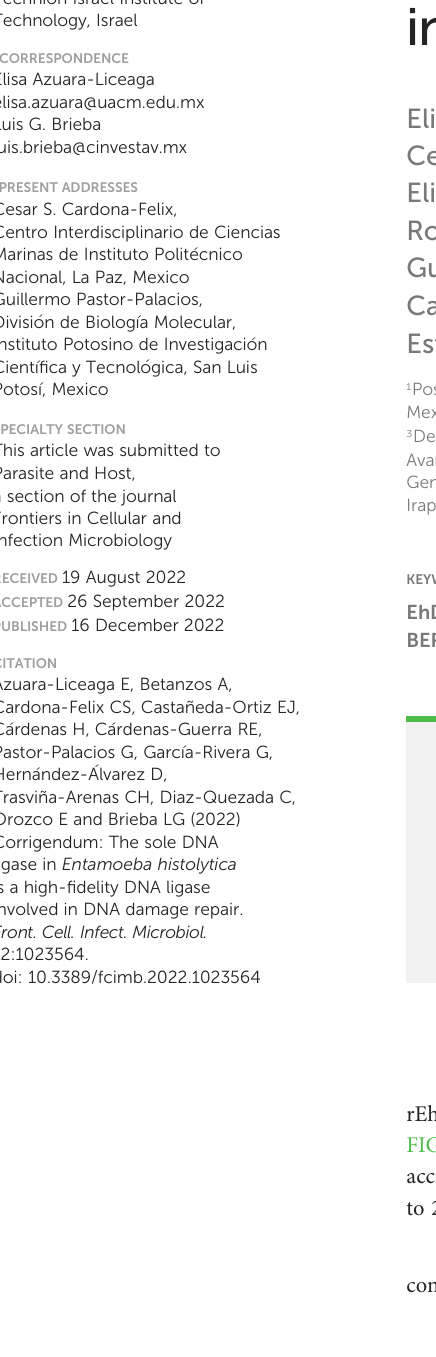
FIGURE 1B, part of the fi gure that corresponds to lanes 10 to 18 (G:T mismatch) was accidentally duplicated in the part of the fi gure that corresponds to the A:T pair (lanes 19 to 26). The corrected FIGURE 1B and its caption appear